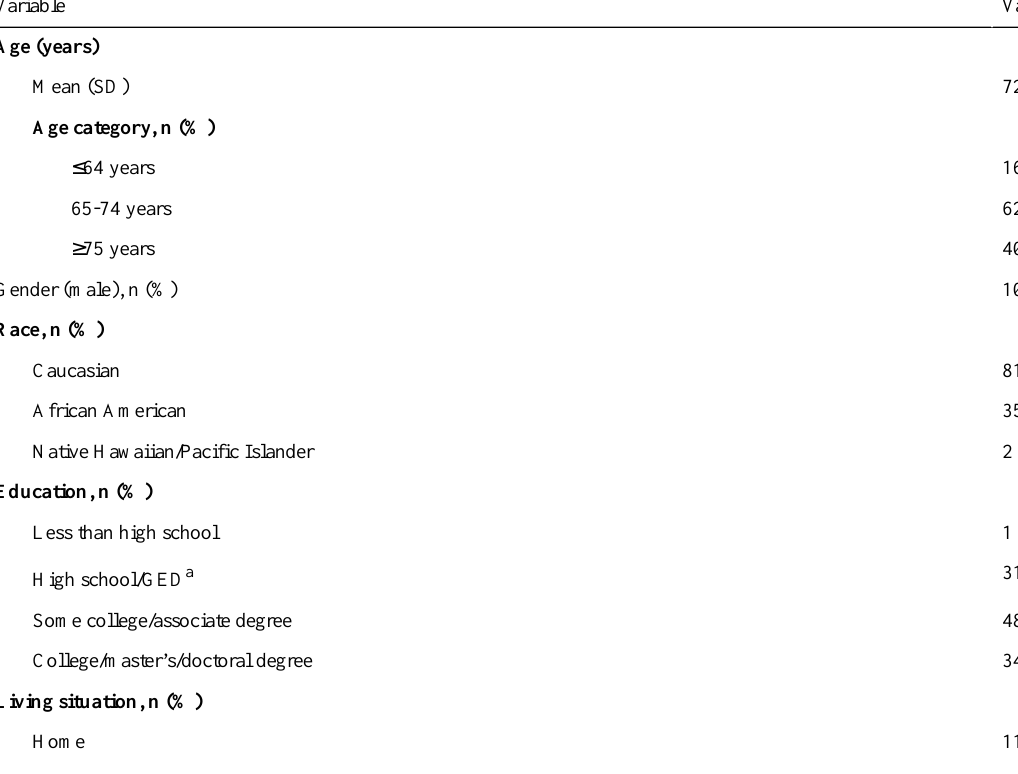
Table 1. Demographics and descriptive statistics